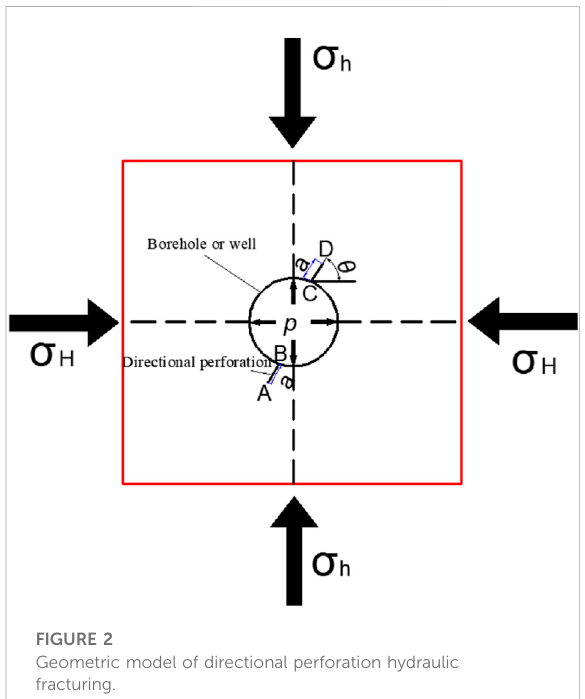
FIGURE 2 Geometric model of directional perforation hydraulic